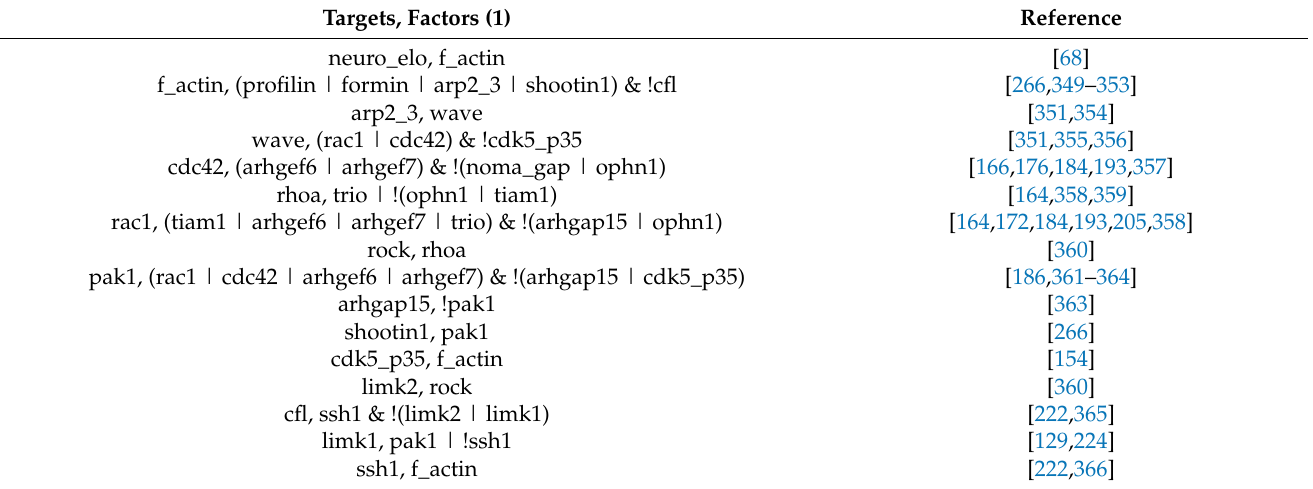
Table 1. Boolean model of the GTPases network for neurite